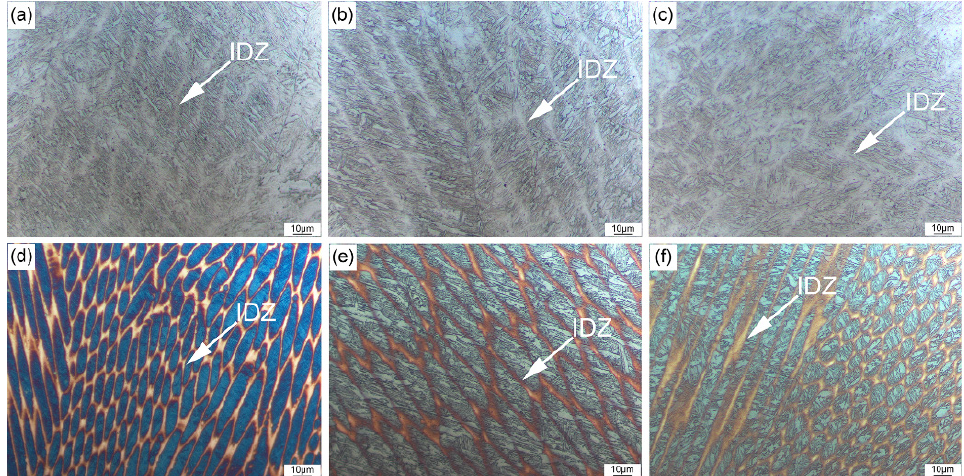
Figure 2. Optical micrographs of the column zone of the deposited metals etched by 4% nital: ( a ) Ni5.5, ( b ) Ni6.5, and ( c ) Ni7.5; Interdendritic zone (IDZ) indicated by white arrows; Optical micrographs of the column zone of the deposited metals revealed by Lepera etchant: ( d ) Ni5.5, ( e ) Ni6.5, and ( f ) Ni7.5.